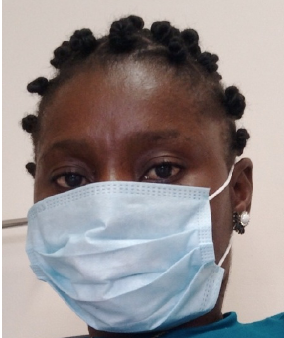
Figure 11. Alt-text: Young woman wearing a blue face mask.